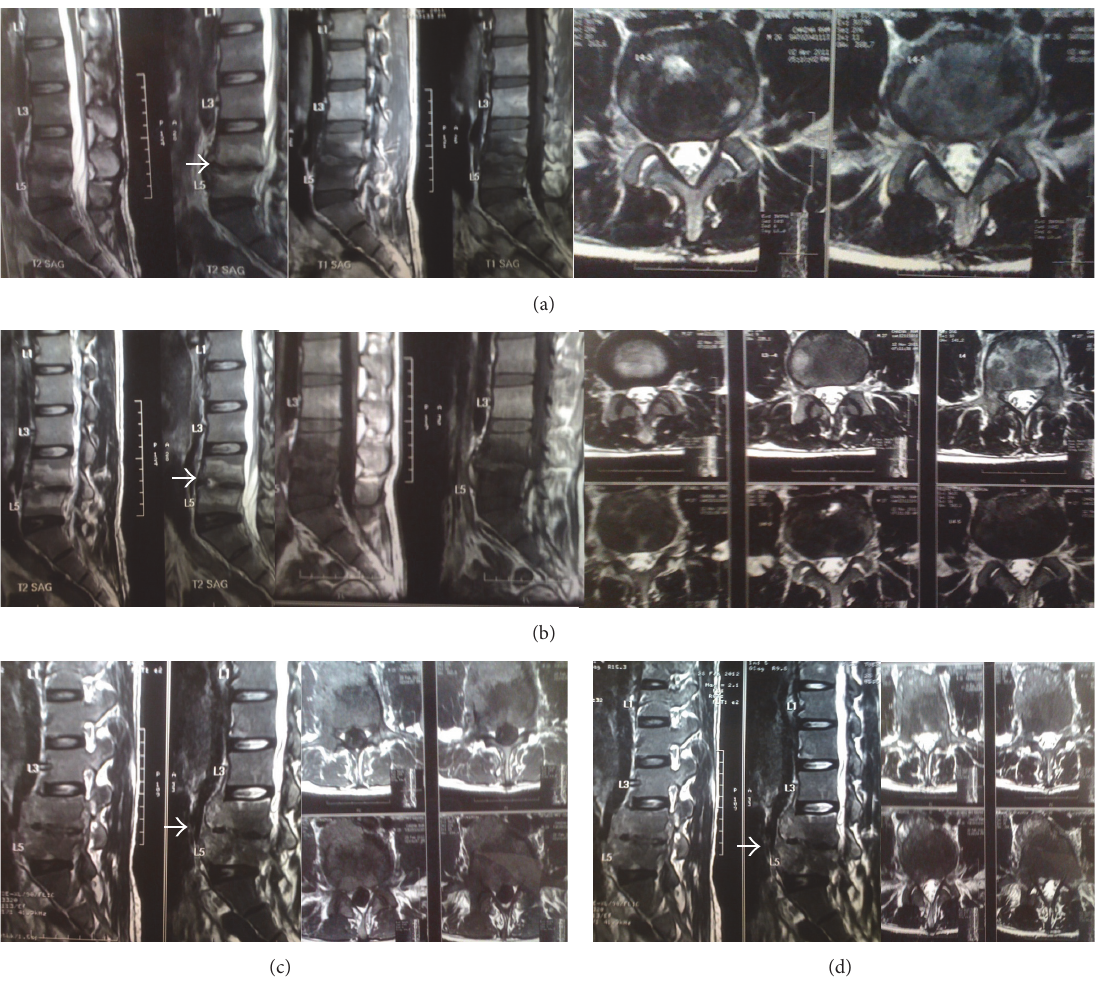
Figure 1: Sequential MRI images of the patient. (a) MRI before the initiation of anti-Koch’s therapy. (b) MRI image after 4 months of anti- Koch’s therapy. (c) MRI image after 9 months of anti-Koch’s therapy. (d) MRI image after 12 months of anti-Koch’s